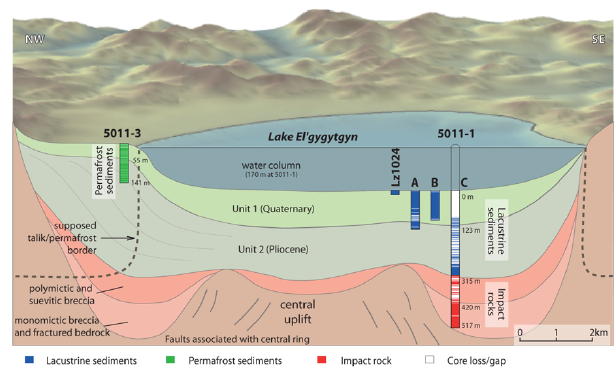
Fig. 2. Basin scheme of the Lake El’gygytgyn site with the digital elevation model in the background. The numerical model is based on this conceptual model by Melles et al.